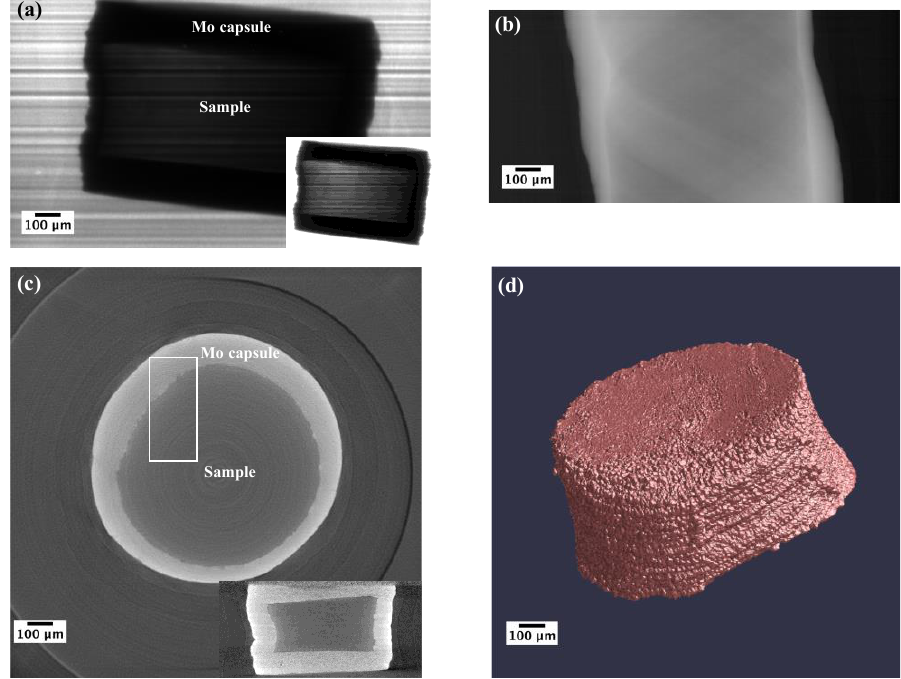
Figure 2. Steps for tomographic reconstruction. ( a ) A representative raw radiographic image obtained for the sample at 3.7 GPa and 1934 K. The inset is the same image after adjusting brightness and contrast. ( b ) Sinogram showing the stack of line integrals of the pixel values at a given row height within the sample. ( c ) Reconstructed horizontal slice (viewed from the top) using the TOMO_DISPLAY program. The inset shows the reconstructed vertical slice (viewed from the side). The rectangular area is zoomed in Figure 3 showing the filtering and separation processes. ( d ) 3D volume rendering of the sample using Blob3D. The Mo capsule was removed for clarity in this view.